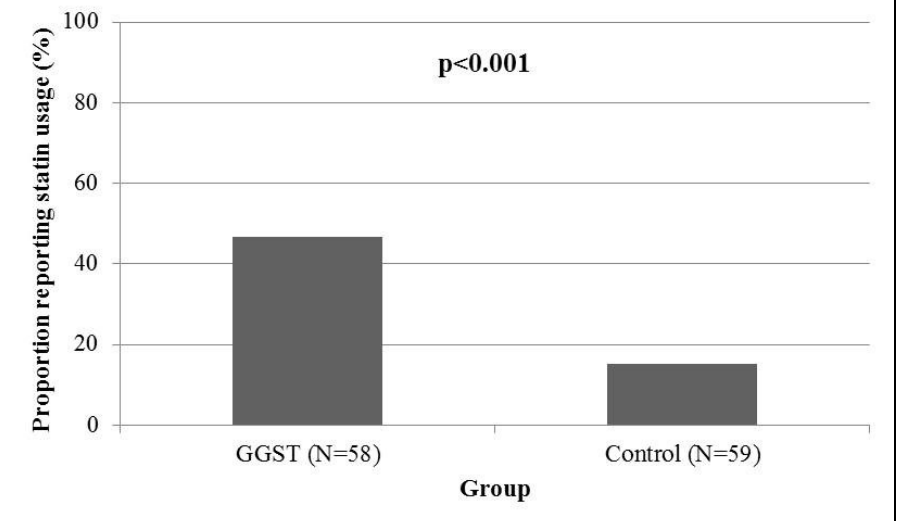
Figure 3. Association of GGST with subject-reported statin utilization. Individuals receiving GGST had a higher subject-reported statin utilization (47%) following genotyping compared to control subjects (15%) over a one-year period. GGST = genotype guided statin